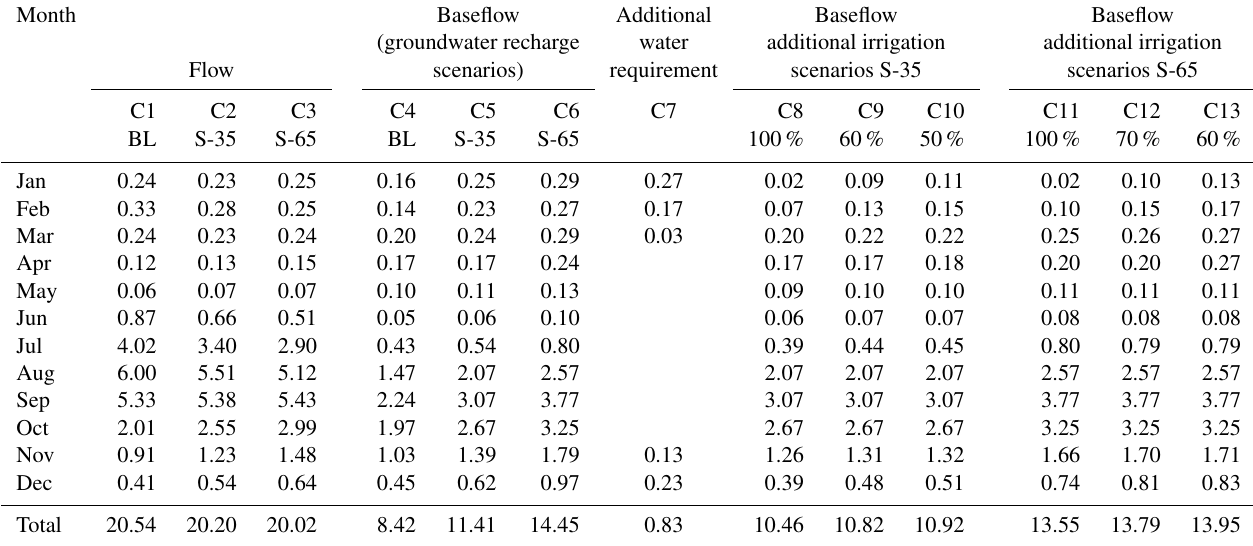
Table 5. Mean monthly distribution of river flow and baseflow in the Ramganga sub-basin under different groundwater recharge and abstrac- tion scenarios (BL – baseline scenario; S-35 – 35% increase in groundwater recharge; S-65 – 65% increase in groundwater